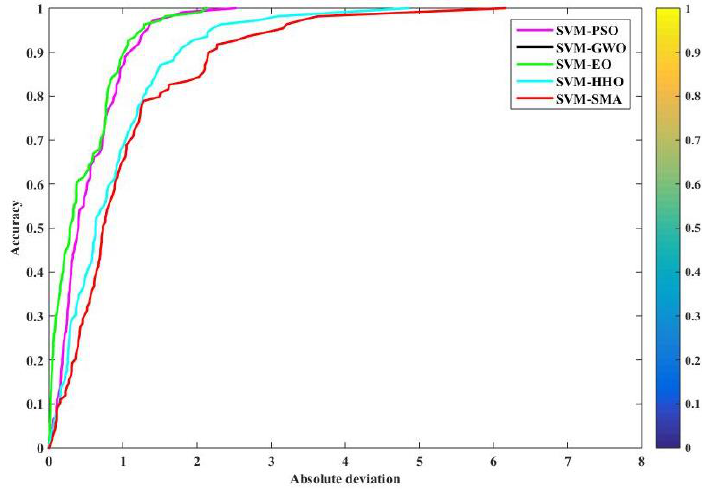
Figure 9. REC curves for training.